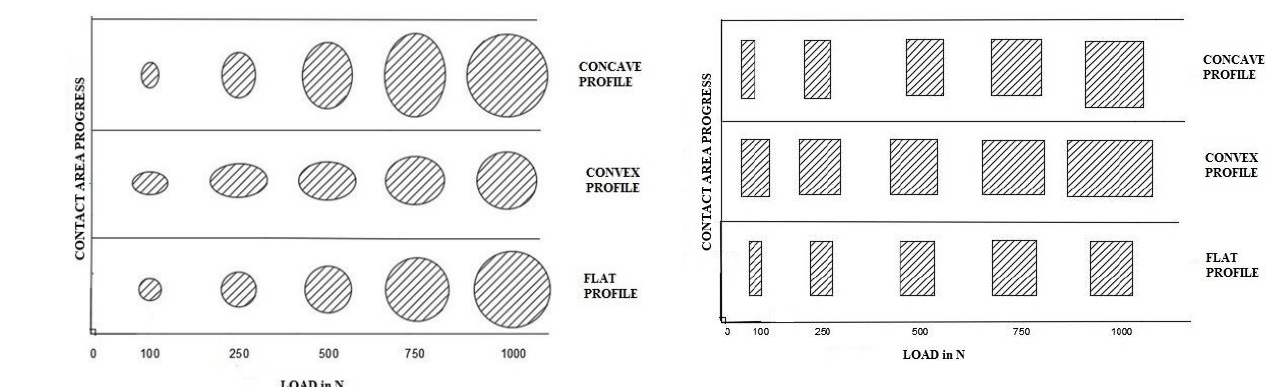
Figure 8: Contact area progress of cylindrical fingertip on various